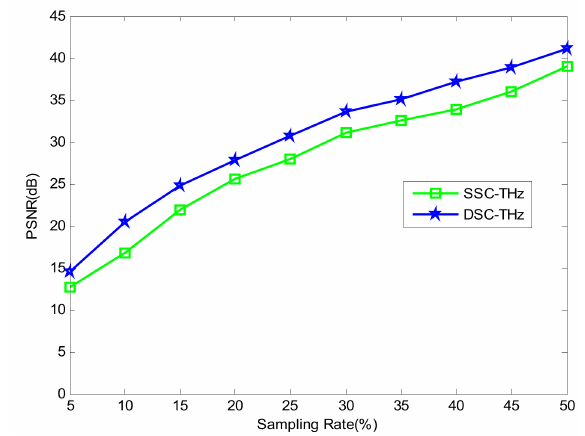
Figure 6. Comparison of the PSNR to different sampling